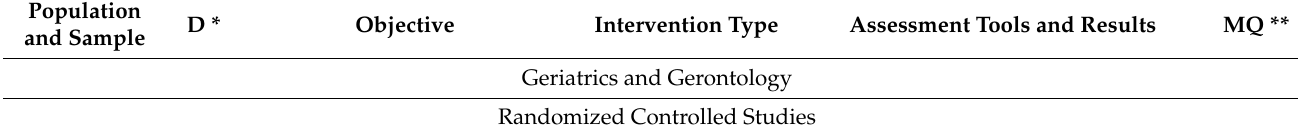
Table 3. Synopsis of findings for randomized controlled studies, systematic reviews and